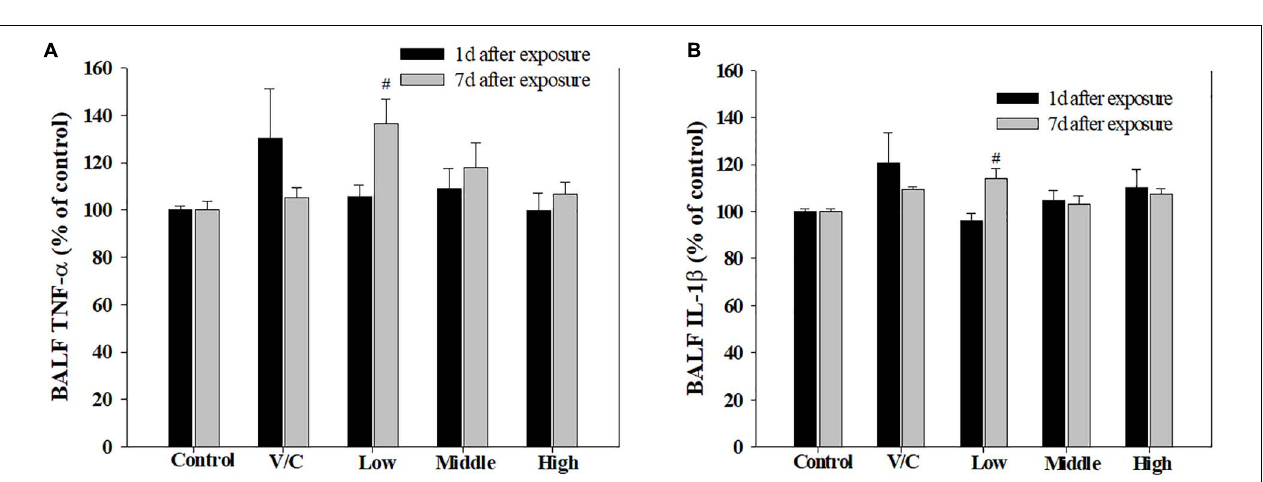
FIGURE 9 | Pulmonary toxicity induced by repeated inhalation of a mixture of SM and PG for 2 weeks in male rats. (A) TP content in BALF and (B) level of LDH in BALF. The values are presented as the mean ± SE (one-way ANOVA followed by Tukey’s multiple comparison test, # P < 0.05, ## P < 0.01, and ### P < 0.001 vs. control).